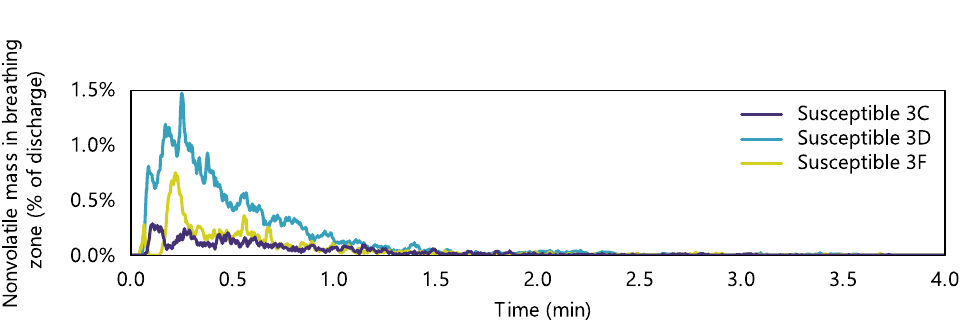
Figure 3. Decay of expiratory particles over time after cough discharge. ( a ) Airflow at 100% with different index seats and initial conditions. ( b ) Airflow at 55–100% with index passenger in aisle seat 3D.